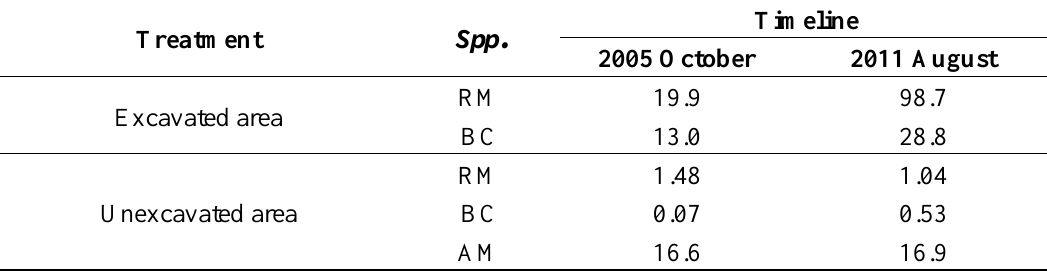
Table 2. Estimation of the standing biomass